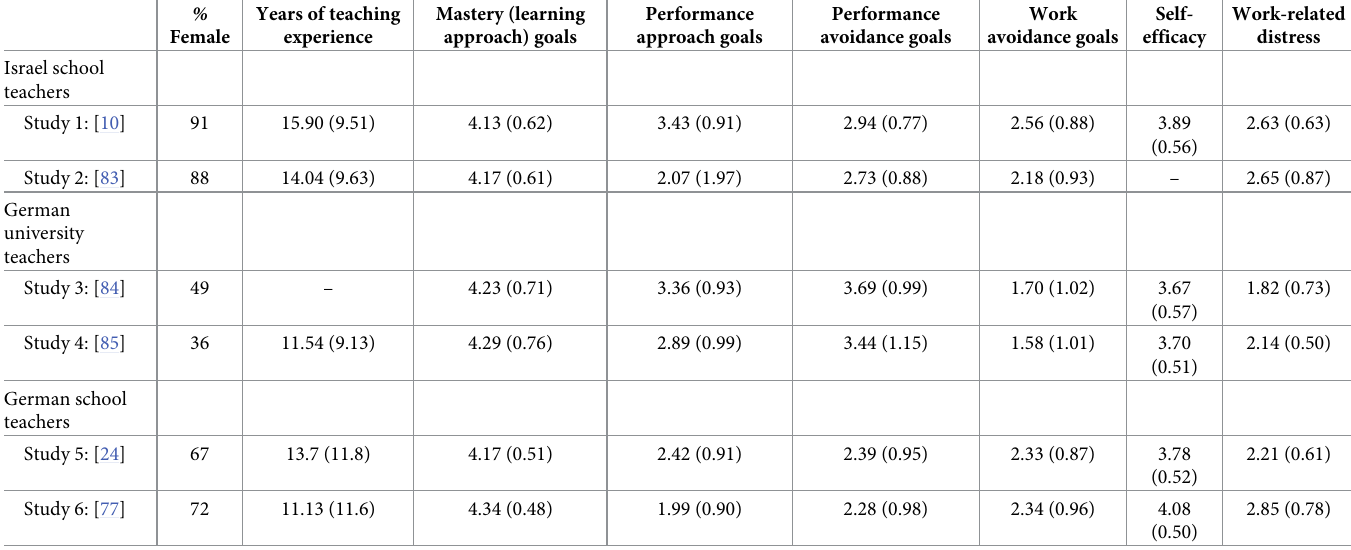
Table 2. Descriptive statistics for all included datasets (displayed are percentages for the proportion of female and means and standard deviations for the remaining characteristics). %